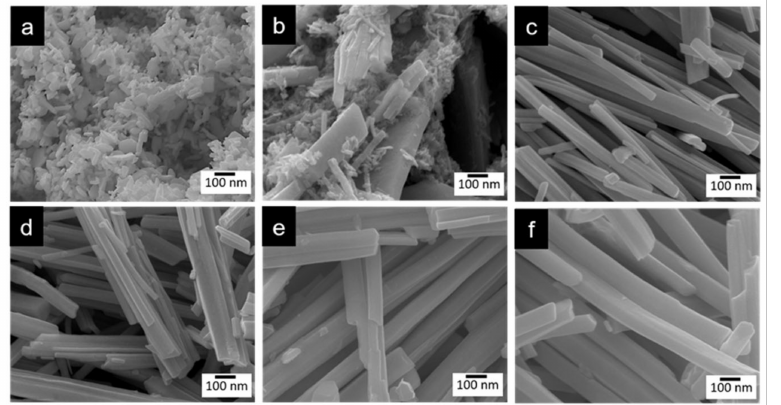
Figure 1. SEM images of ( a ) WO 3 − 0, ( b ) WO 3 − 0.62, ( c ) WO 3 − 1.2, ( d ) WO 3 − 2.5, ( e ) WO 3 − 5, and ( f ) WO 3 − 7.5.